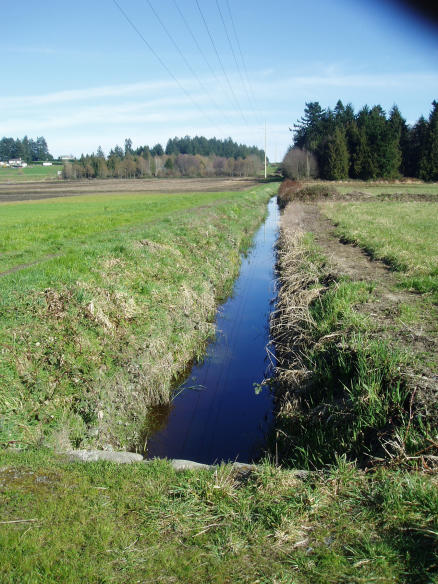
The CreekMany parts of the creek have been straightened to produce ditches that lead to faster run-off; an industrial park behind the tall trees to the right spills heavy metals and other pollutants into this part of the creek, affectionately called “stinky ditch.”